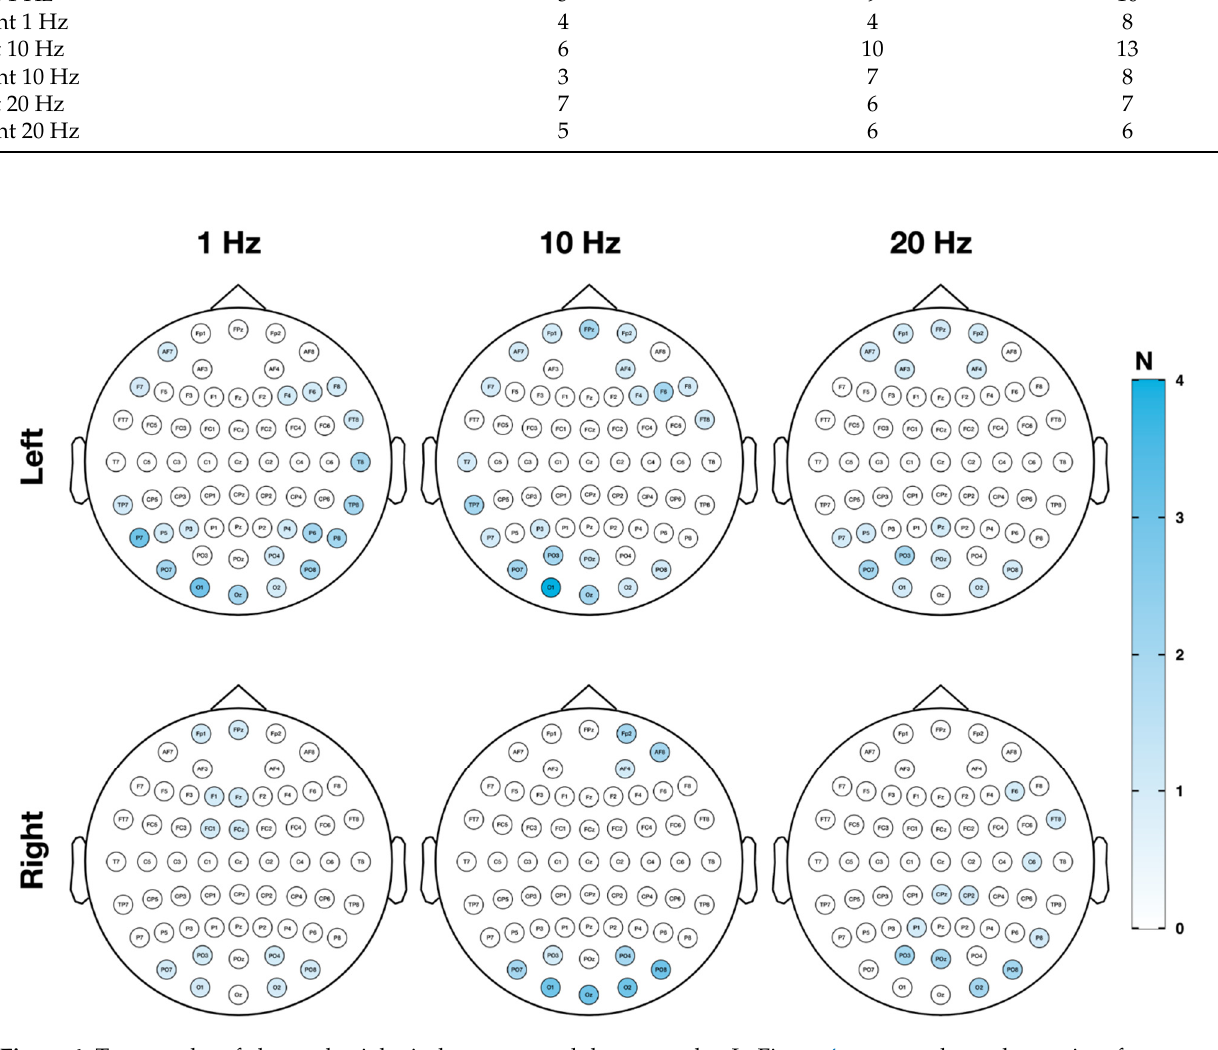
Figure 4. Topography of electrophysiological response—alpha responder. In Figure 4, topography and quantity of sensors showing sham-superior increases in the alpha frequency band in a minimum number of two neighboring channels on both test session days are illustrated per rTMS protocol. Responses in the alpha frequency band (8–12.5 Hz) to one of the verum protocols primarily occurred over parieto-occipital electrodes.